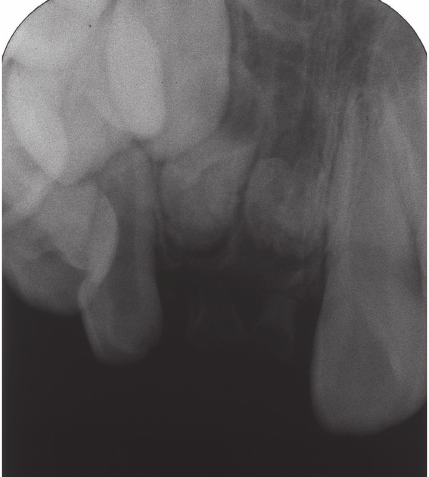
Figure 4: Intraoral findings at initial visit (case 2). The primary maxillary right central and lateral incisors are severely hypoplastic.